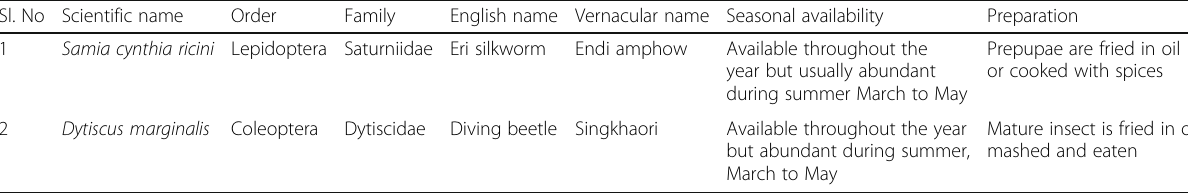
Table 1 Information of the studied